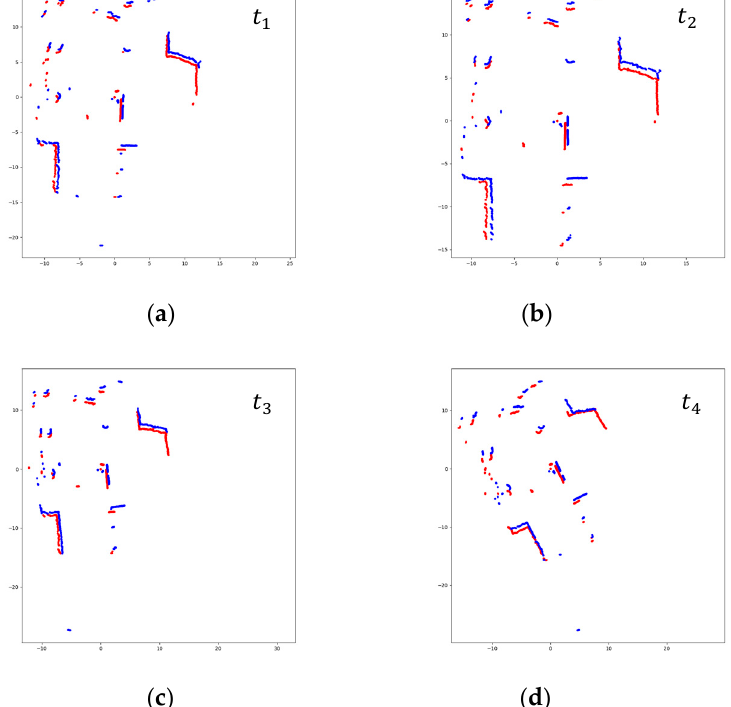
Figure 7. Conversion of scan pairs into images before preprocessing (Red: previous scan, blue: current scan). The areas where scans are plotted are not fixed. ( a ) t = t 1 ; ( b ) t = t 2 ; ( c ) t = t 3 ; ( d ) t = t 4 .